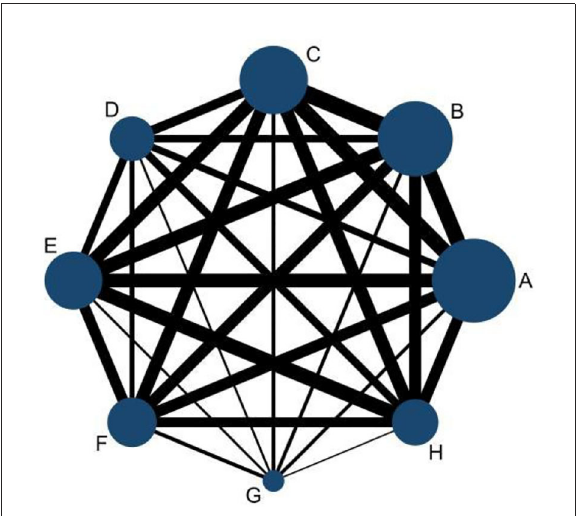
FIGURE2 Network diagram of comparison of different diseases. A, hypertension; B, diabetes; C, heart disease; D, cerebrovascular disease; E, malignant tumor; F, chronic kidney disease; G, chronic liver disease; H, respiratory disease.